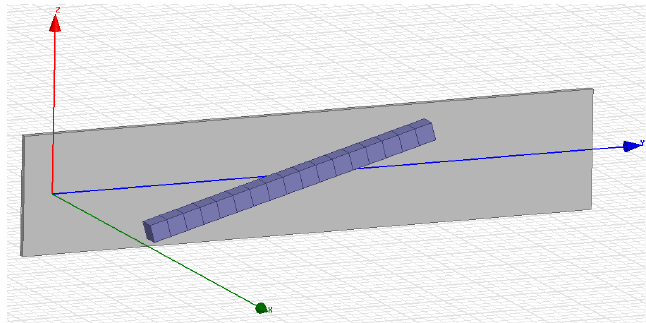
Figure 7. Three-dimensional simulation model.